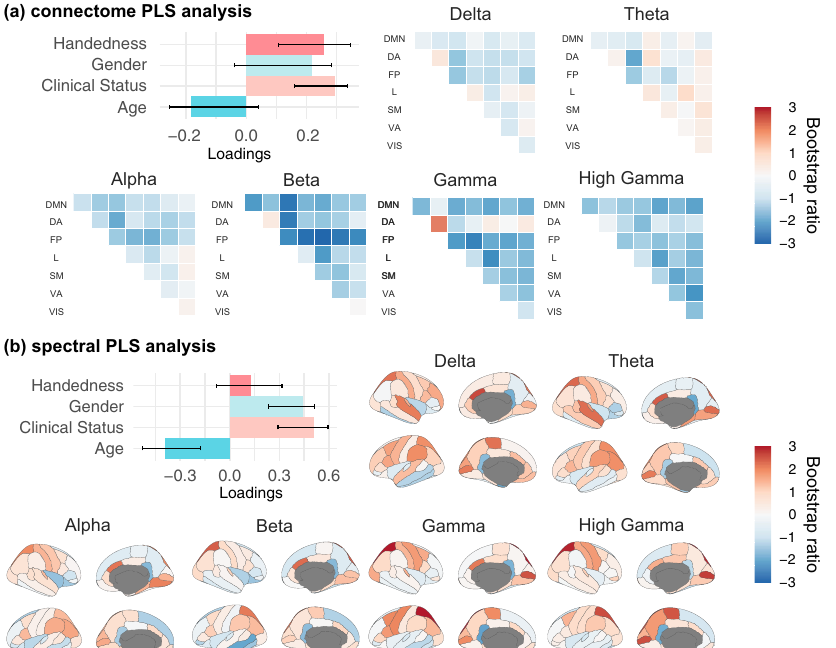
Fig. 5 Partial Least-Squares analysis relates demographics to connectome and spectral features. ( a ) and ( b ) from left to right, depicts the design saliency patterns for the fi rst latent variables and their associated neural-data bootstrap ratios. Con fi dence Intervals (95% CI) were calculated through a bootstrapping procedure ( n = 10,000), and as such may not necessarily be symmetric. Bootstrap ratios computed for ( a ) connectome and ( b ) spectral features are plotted according to the resting-state networks labeled according to Yeo et al. 81 and the Desikan-Killiany parcellation 37 , respectively: Default Mode Network (DMN), dorsal attention (DA), frontal-parietal (FP), limbic (L), somato-motor (SM), ventral attention (VA), and visual (VIS). Source data are provided as a Source Data fi